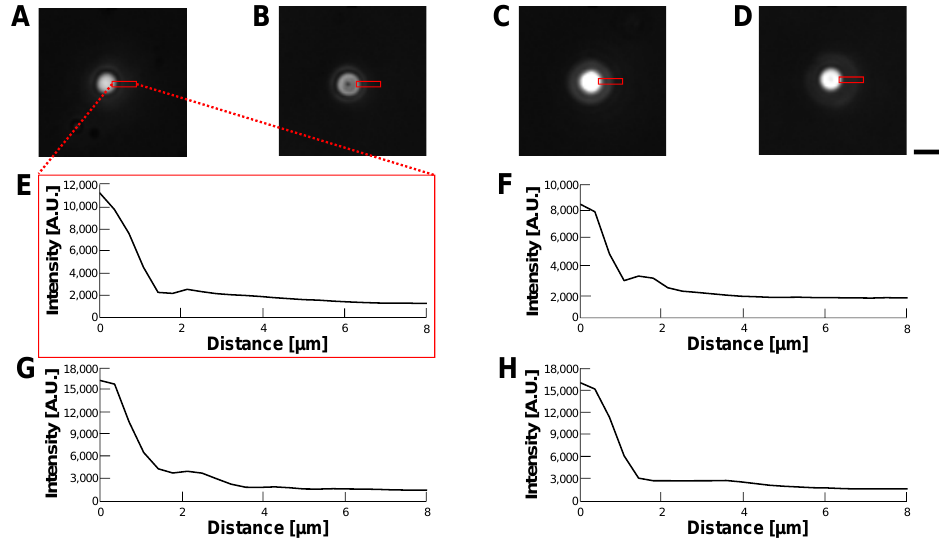
Figure 11. Comparision of permeability of empty alginate microcapsules in various buffer condi- tions by phase-contrast observation. ( A – D ): Phase-contrast images of empty alginate microcapsules. ( A ): 5% glucose solution ( B ): 10% glucose solution ( C ): 15% glucose solution ( D ): 1% alginate